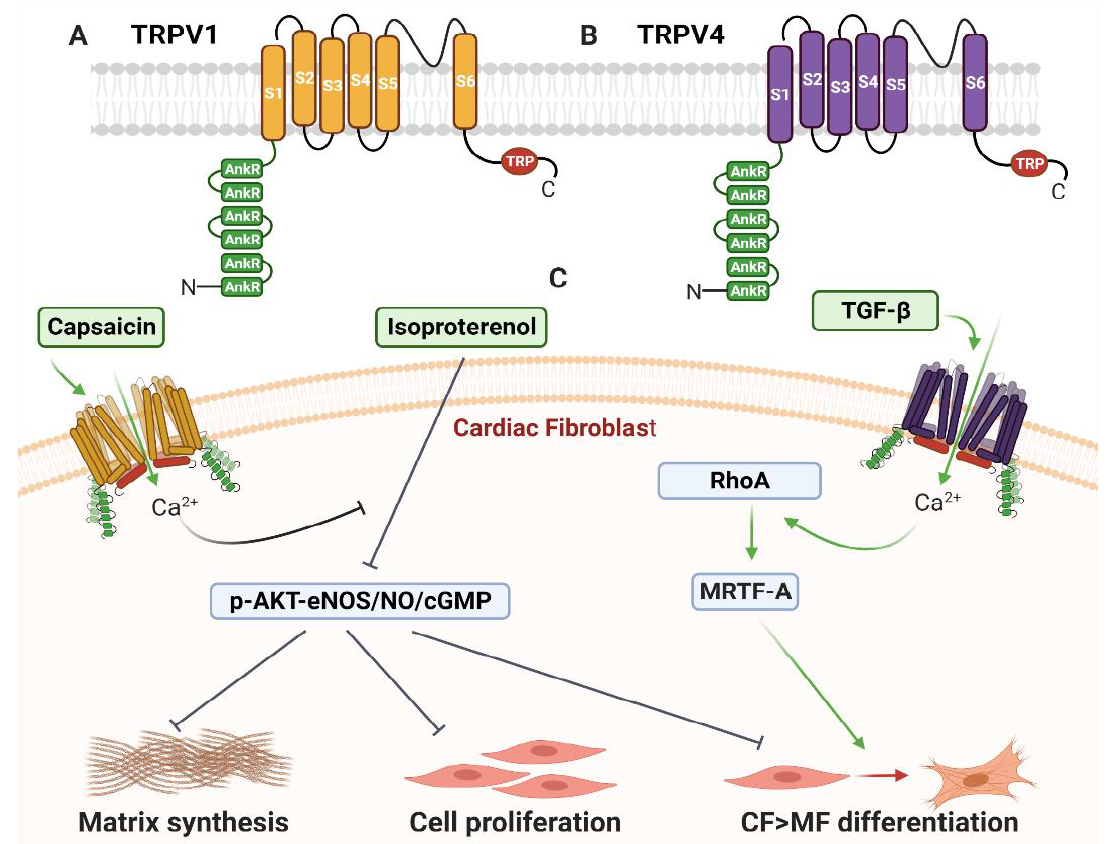
Figure 4. Schematic diagram of TRPV1 and TRPV4 structure and cardiac fibroblast signalling. ( A ) Basic structure of alpha subunit of TRPV1. ( B ) Basic structure of alpha subunit of TRPV4. (A-B) Each TRPV1 and TRPV4 alpha subunit is comprised of six transmembrane-spanning domains (S1–S6), with a pore loop between S5 and S6, ankyrin repeats (AnkR) at the amino terminus, and a TRP-box at the carboxyl terminus. ( C ) Known TRPV1 and TRPV4 homotetrameric ion channel signalling in cardiac fibroblasts. Capsaicin activates TRPV1 and inhibits Ang II-induced cell proliferation. TRPV1 activation also inhibits isoproterenol-induced cell proliferation, and attenuates isoproterenol-induced ECM synthesis, cell proliferation and myofibroblast differentiation by blocking downregulation of p-Akt, p-eNOS, NO and cGMP. TGF- β activates TRPV4, inducing Ca 2+ influx and promoting RhoA signalling, upregulation of MRTF-A transcription factor, and myofibroblast differentiation. See main text for details.